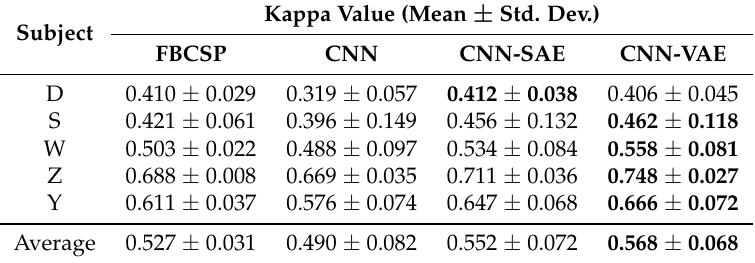
Table 3. Comparison of kappa value and standard deviation for CNN-VAE and 3 Competitive methods on our own dataset with 3 electrodes. (The data in bold is the best performance among the different methods).